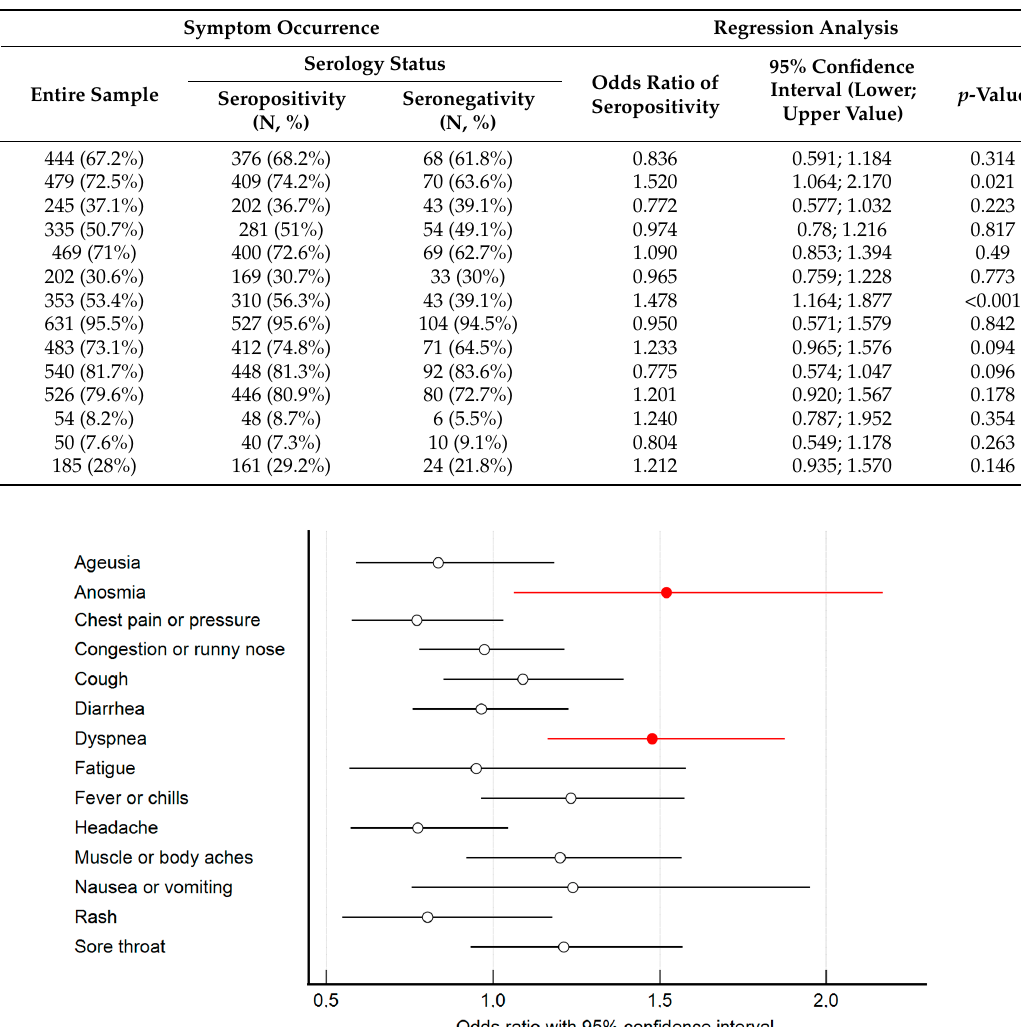
Table 1. Serology status with respect to the presence of particular symptoms.